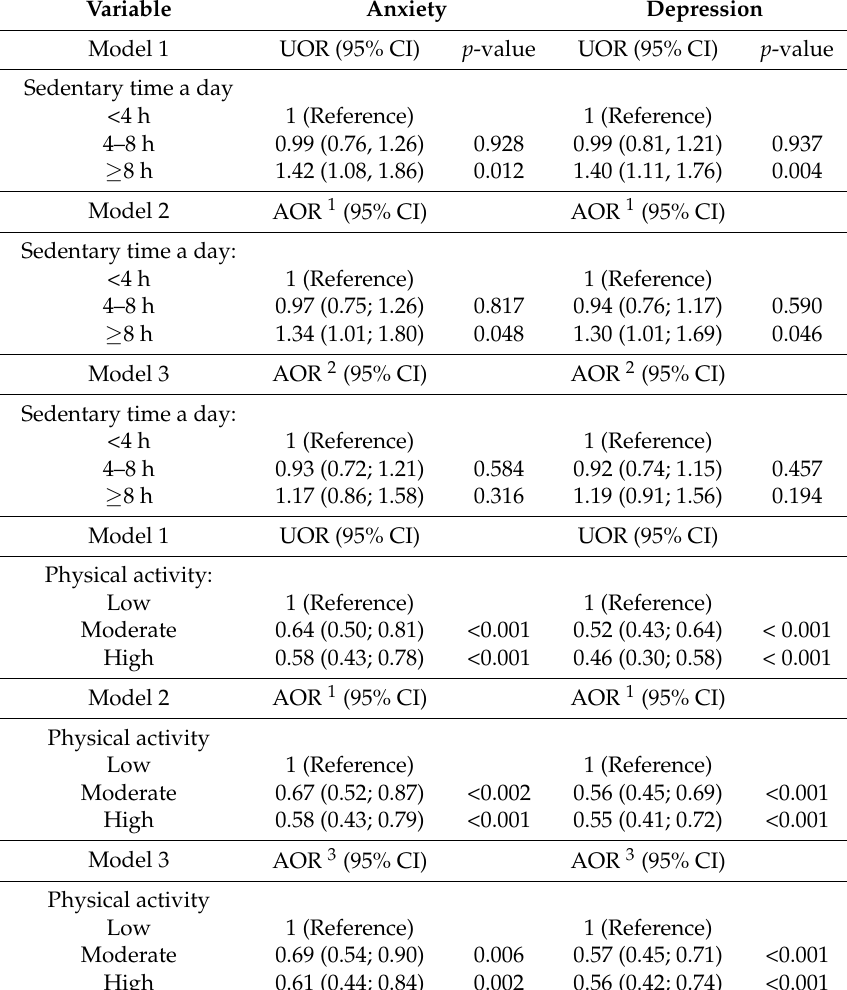
Table 2. Odds ratios for anxiety and depression according to levels of sedentary behaviour and physical